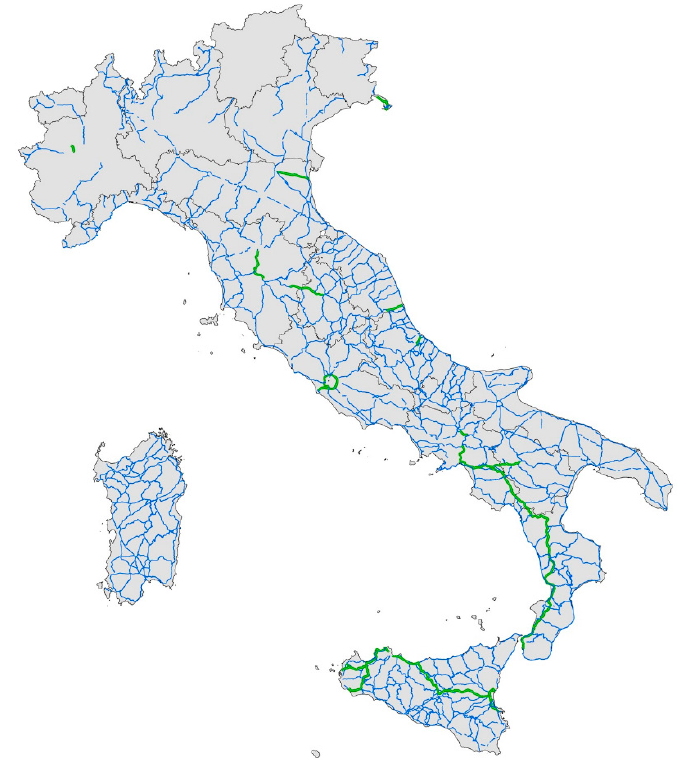
Figure 3. Geographical representation of the road network managed by ANAS S.p.A. as of 10 October 2019.